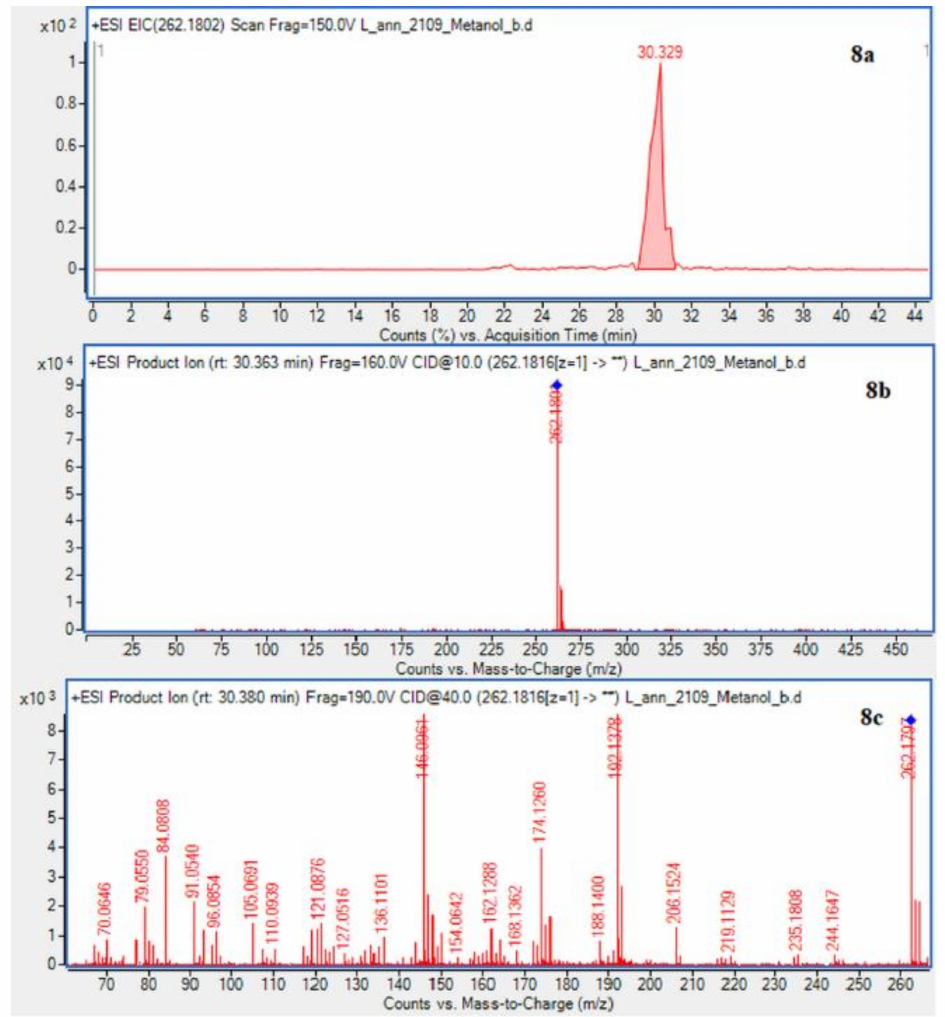
Figure 4. EIC of L. annotinum methanol extract determined by HPLC/ESI-QTOF–MS showing alkaloids: ( 6a )-annotinine at m / z 276.1594 and ( 8a )-acrifoline at m / z at 262.1802. Below CID MS/MS product ion spectra using 10 eV ( b ) and 40 eV ( c ) of collision energy showing the protonated molecules fragmentation